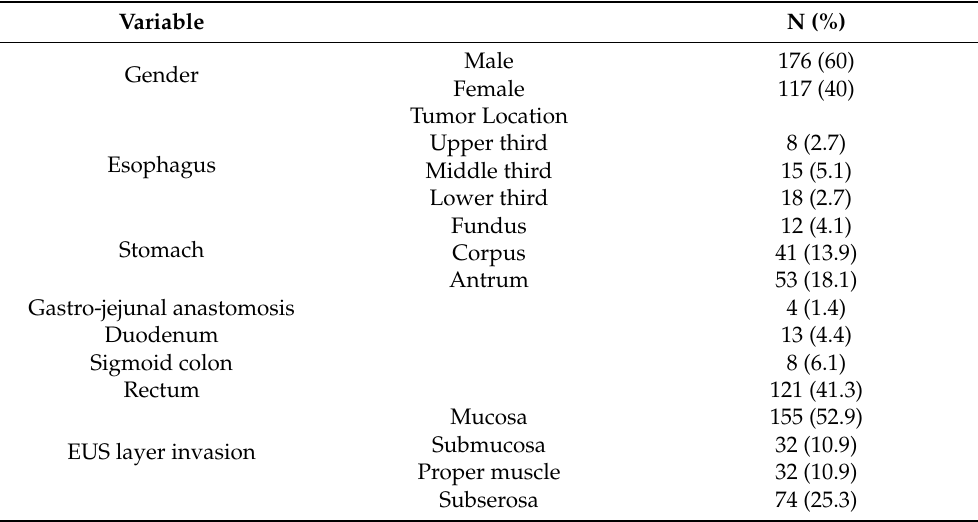
Table 2. Clinicopathologic characteristics of 293 patients submitted to EUS (endoscopic ultrasonogra- phy) staging for GI lesions.